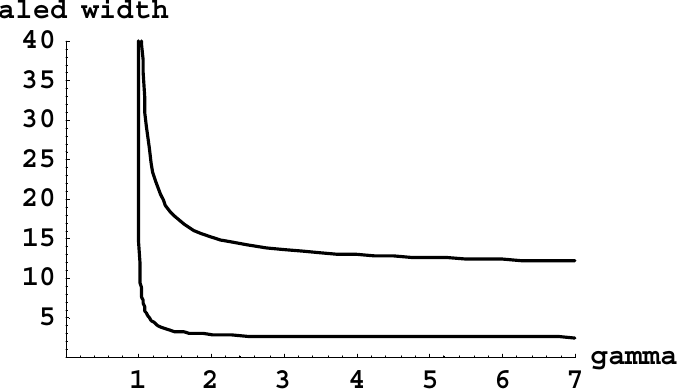
Figure 12. The scaled width of the σ -component Γ σ / η 0 (upper curve) and the scaled width of the π -component Γ π / η 0 (lower curve) of the Ly-alpha line broadened by a Relativistic Electron Beam (REB) versus the relativistic factor γ at N e = 10 15 cm − 3 and T e = 2 eV [82].